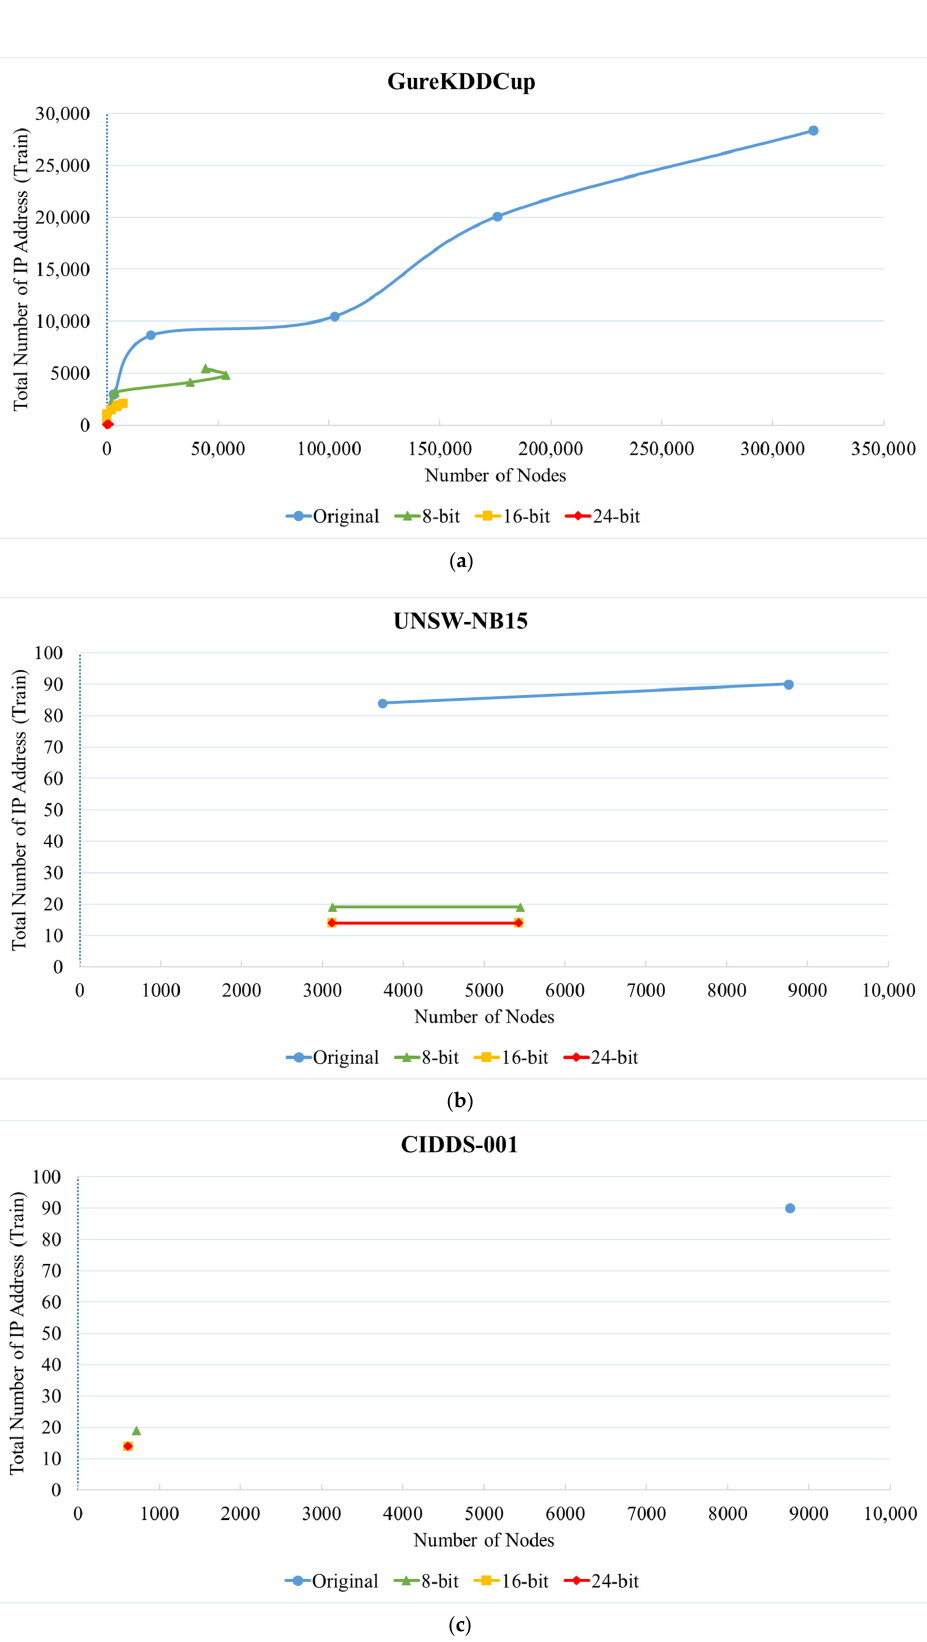
6. Performance Comparison Using Wilcoxon Signed ‐ Rank Test